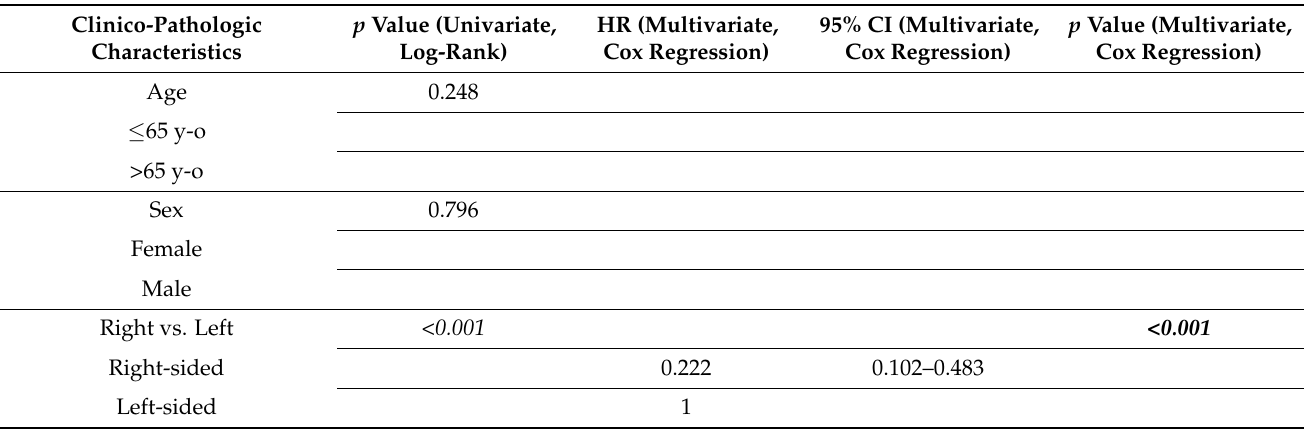
Table 4. Univariate and multivariate analysis for SAR in RAS-wt